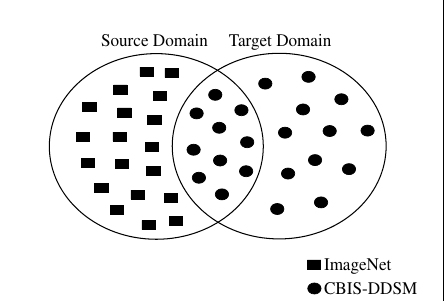
Figure 3. Sketching the instances transferring in single-shot transfer learning (SSTL), where some instances from similar D t (CBIS-DDSM) are included in the D s (ImageNet) to update the weights in the pre-trained models.